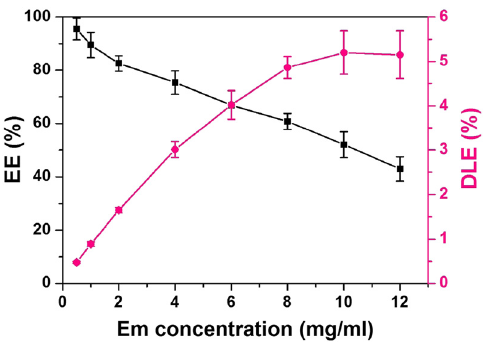
Figure 4: Encapsulation e ffi ciency ( EE ) and drug loading e ffi ciency ( DLE ) . EE and DLE after adding di ff erent concentrations of Em ( 1 – 12 mg/mL ) .